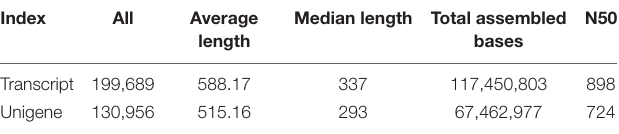
TABLE 4 | Genome assembly quality evaluation.